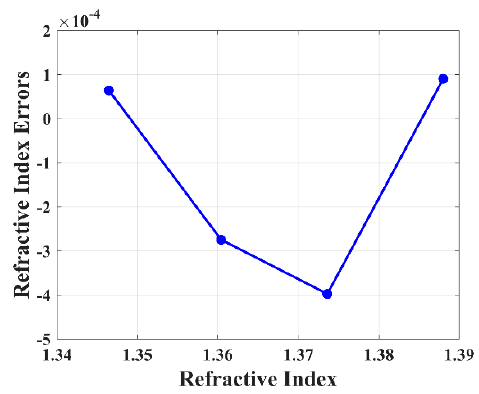
Figure 6. The measurement errors in five different RI liquids.